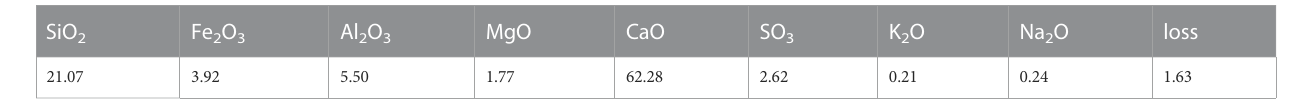
TABLE 1 Chemical composition of cement (%).